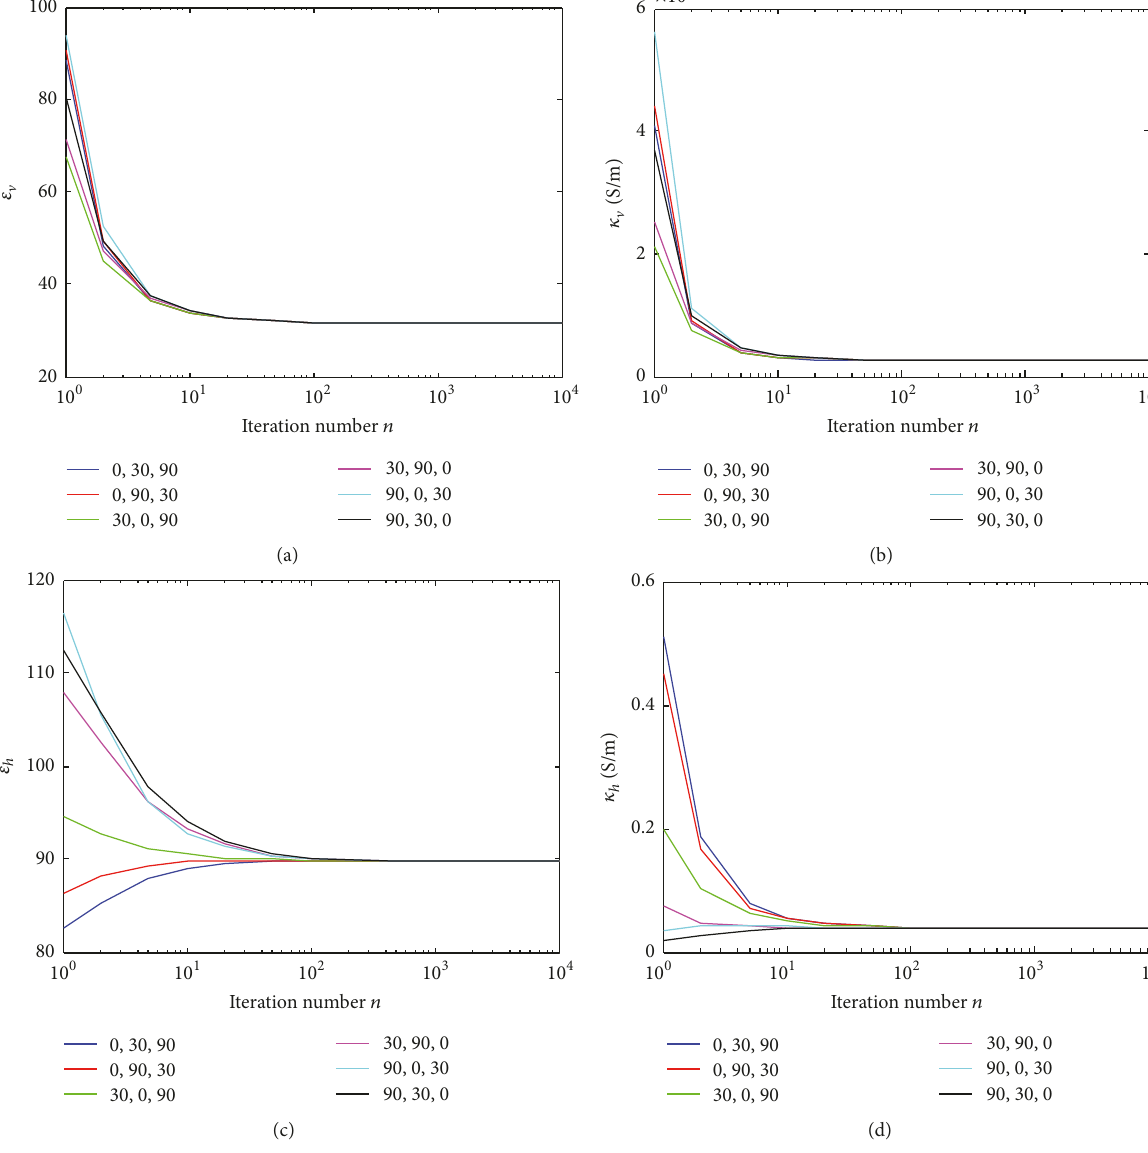
Figure 3: Simulated relative permittivity and conductivity of the hypothetical sample in the directions when the applied electric field is perpendicular ( 𝜀 V and 𝜅 V , resp.) and parallel ( 𝜀 ℎ and 𝜅 ℎ , resp.) to the bedding, respectively. The lines with varying colors are for the quartz grains with different mixing orders, where 0, 30, and 90 stand for the quartz oriented 0 ∘ , 30 ∘ , and 90 ∘ to the bedding,